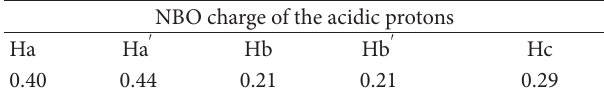
T 3: NBO charges of the acidic protons of compound 5c calculated at the DFT/B3LYP level of theory.